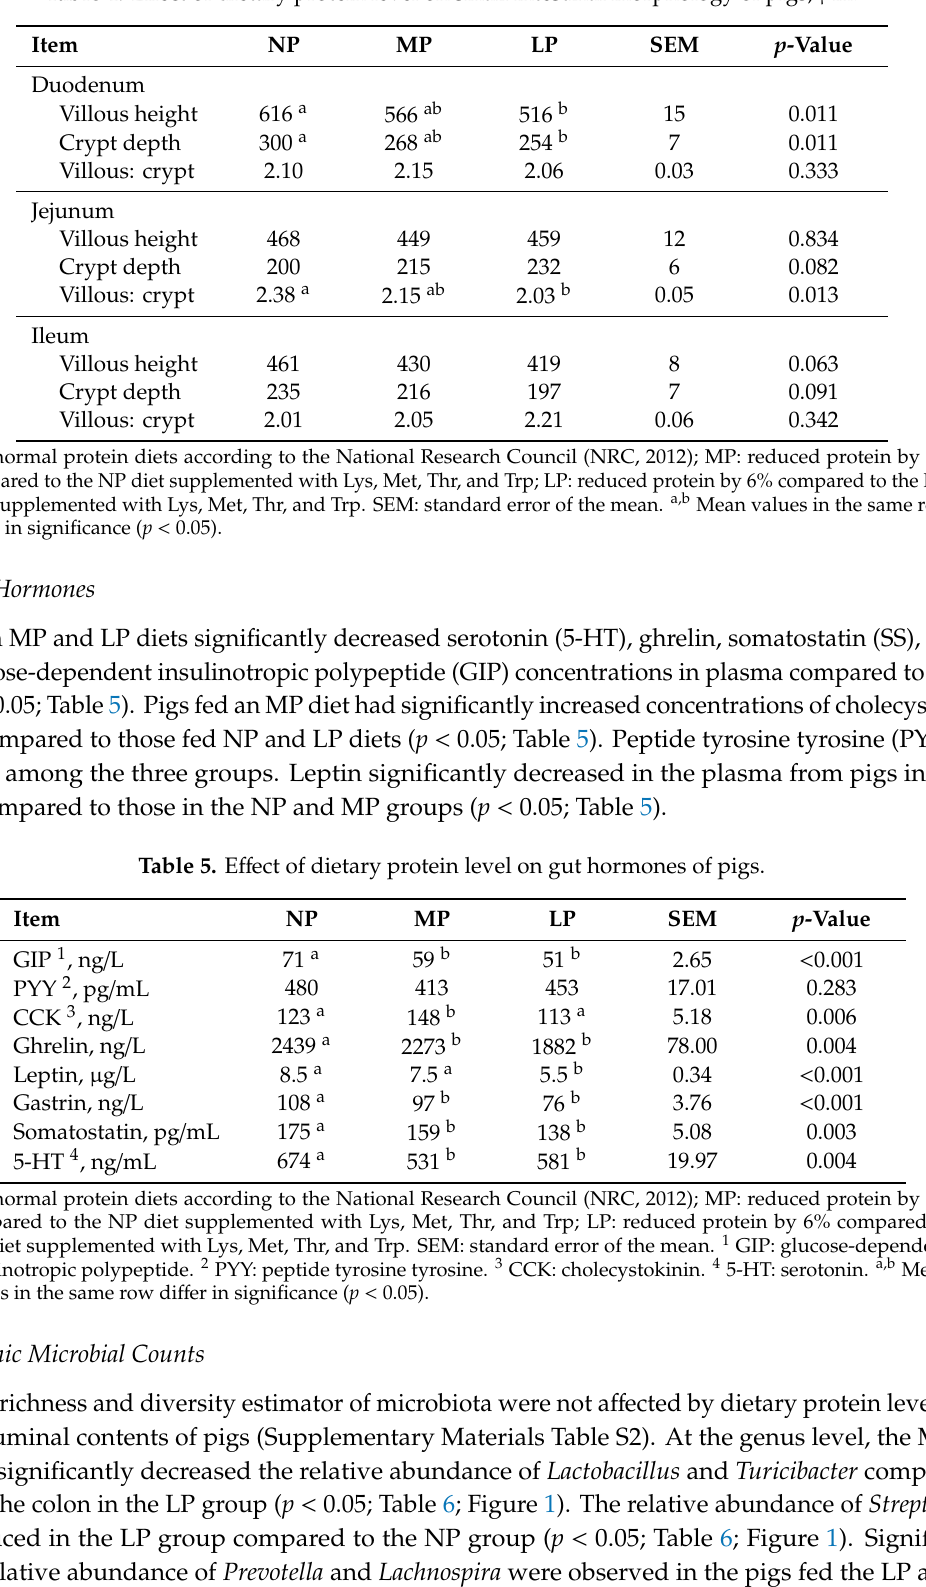
Table 4. E ff ect of dietary protein level on small intestinal morphology of pigs, µ m.